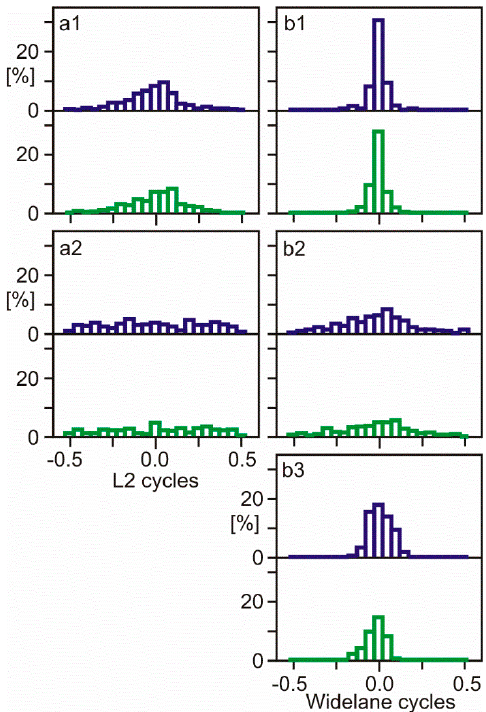
Figure 3. Distribution of fractional ambiguities after the alignment of L2P(Y)/L2C carrier phase observations. The same observation stations and identical figure structure as Figure 2 are used.